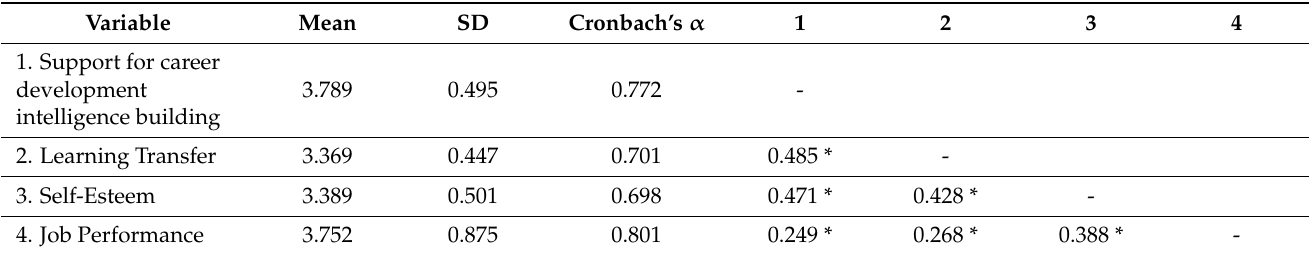
Table 3. Number, Means, Standard Deviations, Cronbach’s α , Correlations, and Reliabilities of Study Variables.